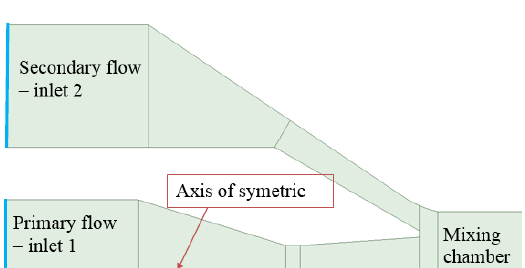
Fig. 8. Partitioning of the parts before creating the mesh,